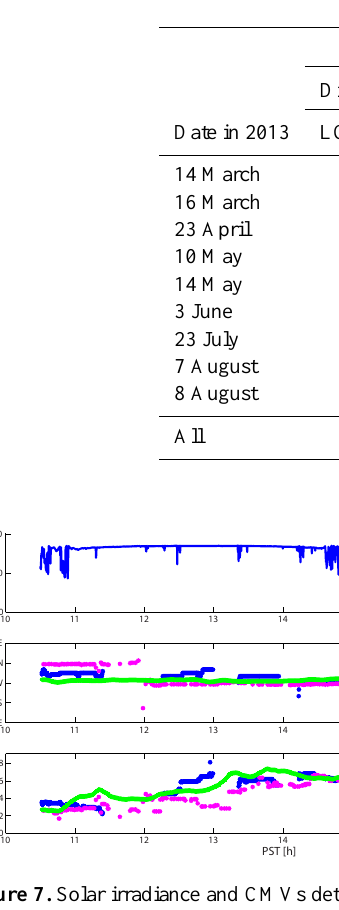
Table 3. RMSD and MB of CSS results compared to LCE and USI. Due to incorrect cloud height observed, no cloud motion results were detected from USI on 14 March and 10 May. LCE results are excluded for 23 April due to a shortage of results that pass QC.